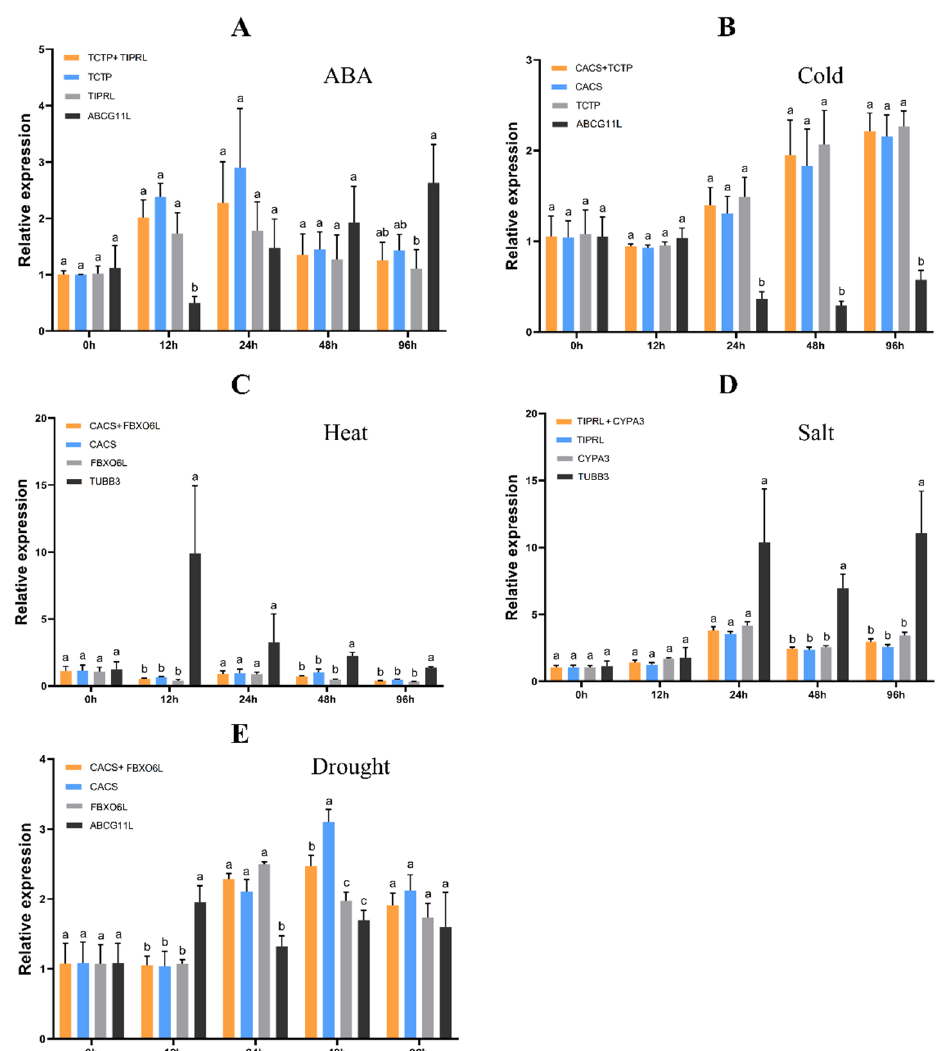
Figure 5. The relative expression levels of CAT1 genes under different treatments were normalized by the two most stable genes and the least stable genes. Different letters at the same time point indicate significant differences between reference genes or combinations at the 0.05 level. The bars indicate the standard error (±SE).